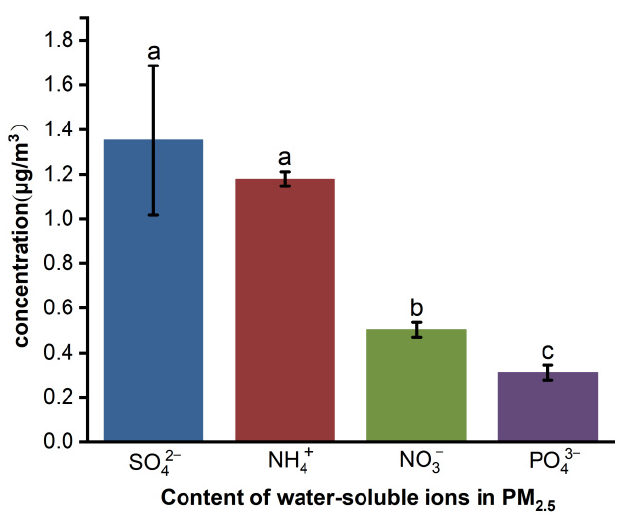
Figure 4. The contents of several water-soluble ions in PM 2.5 . Note: Different superscript letters in the same column represent significant variation ( p ≤ 0.05), while the same letters represent no significant variation ( p > 0.05).